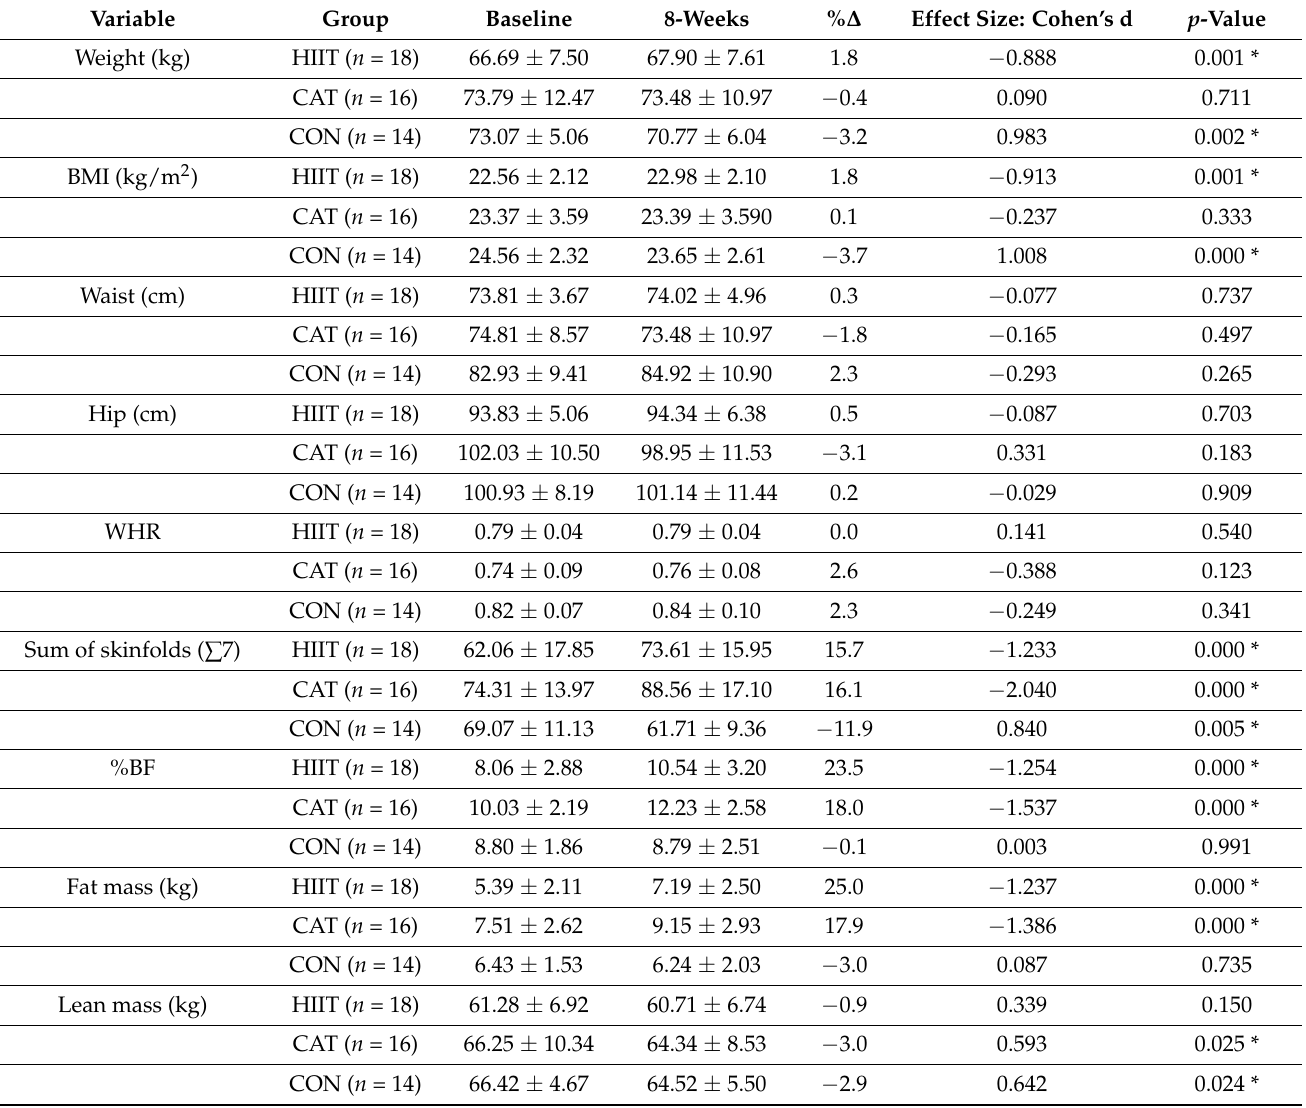
Table 3. Intra-comparisons of anthropometric variables (weight, height, body mass index, waist, hip, waist-hip ratio, sum of skinfolds, %body fat, fat mass, and lean mass) in college-aged smokers following 8 weeks of high-intensity interval training (HIIT), continuous aerobic training (CAT), and a control group